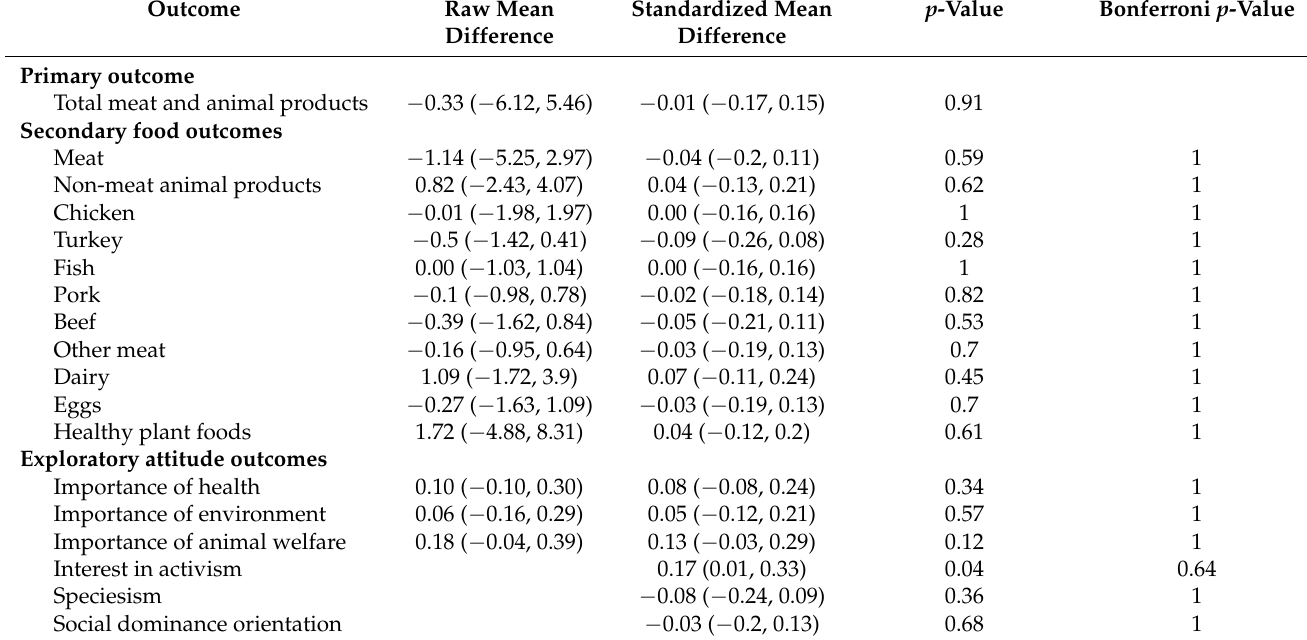
Table 2. In Study 1, estimated intervention effects for the primary outcome, secondary food outcomes, and exploratory attitude outcomes. Raw mean differences represent ounces consumed over the past week for the primary outcome and secondary food outcomes; they represent units on a 7-point Likert scale for the perceived importance items; and they are omitted for the three composite scales, which were already standardized. Brackets are 95% confidence intervals without correcting for multiple